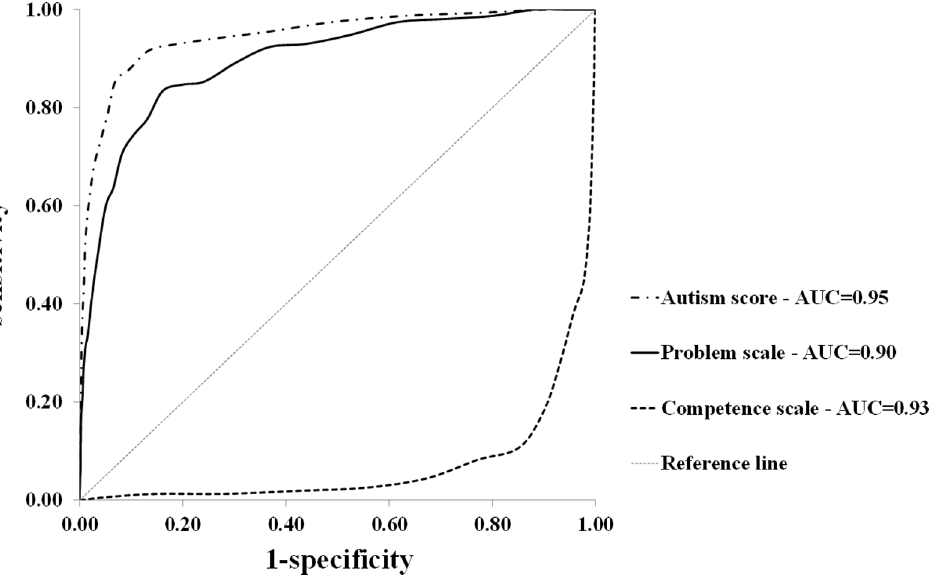
Figure 1. ROC curves and AUC of the BITSEA Problem and Competence scale and BITSEA Autism score relative to a sample of children with a diagnosis of autism spectrum disorder.